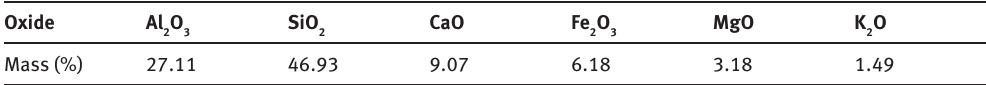
Table 1: Chemical composition of fly ash class C. Oxide Al